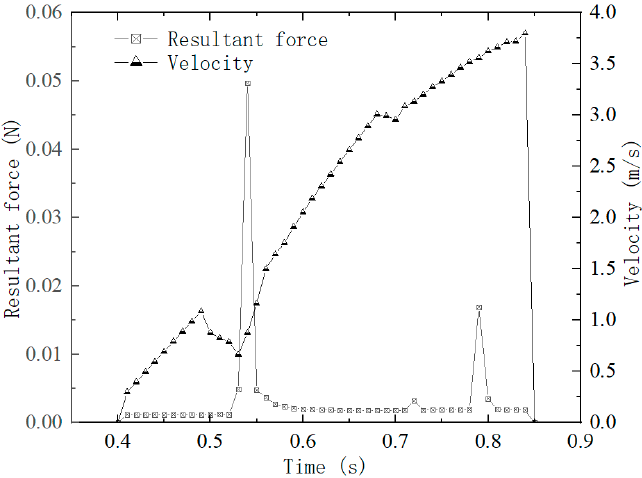
Figure 9. Changes in force and speed of cotton